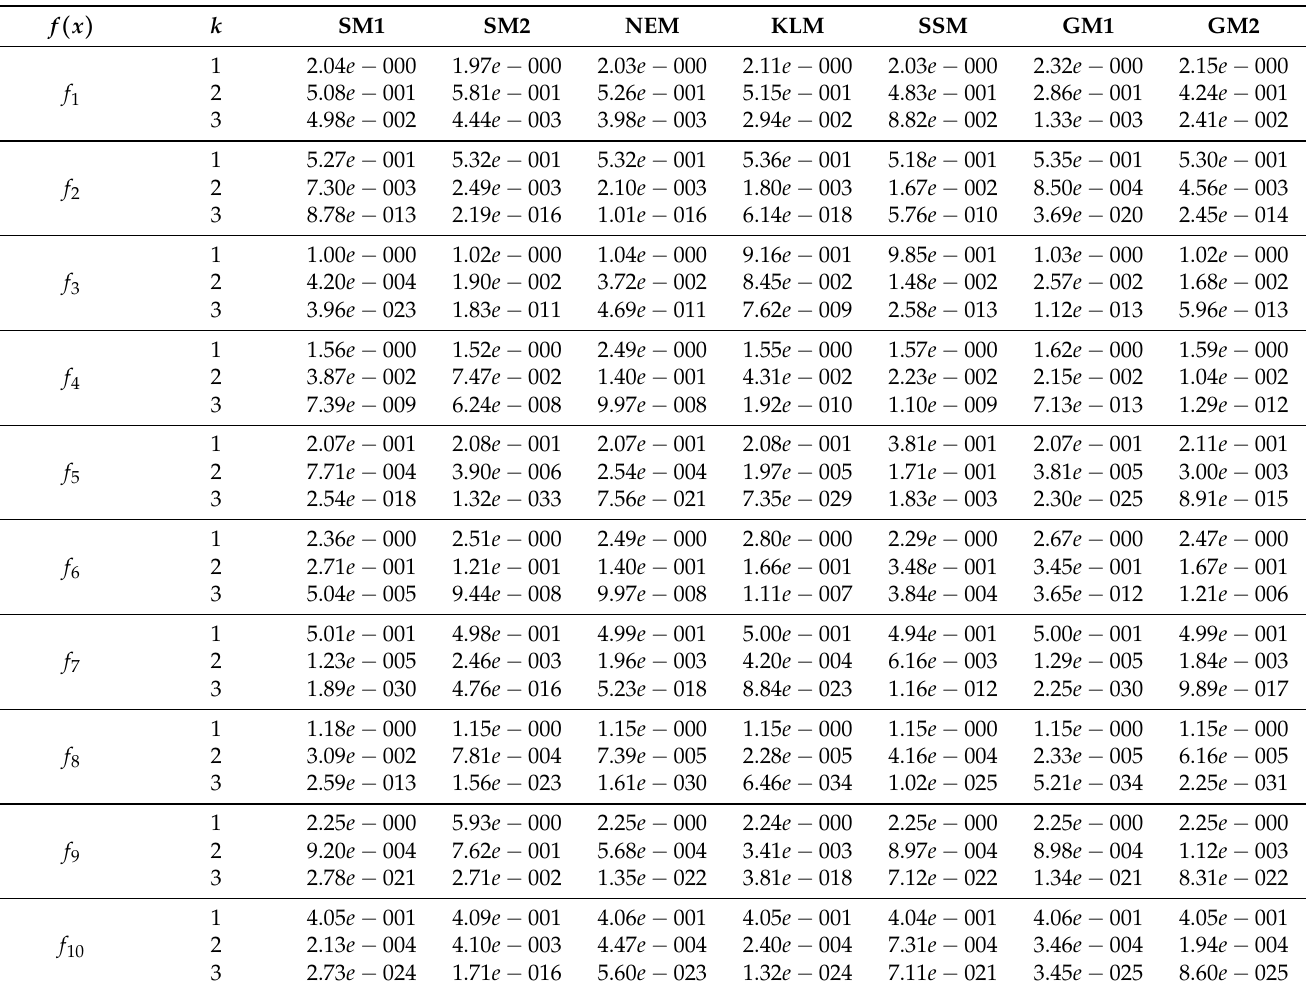
Table 4. Comparison of | x k + 1 − x k | for all methods.